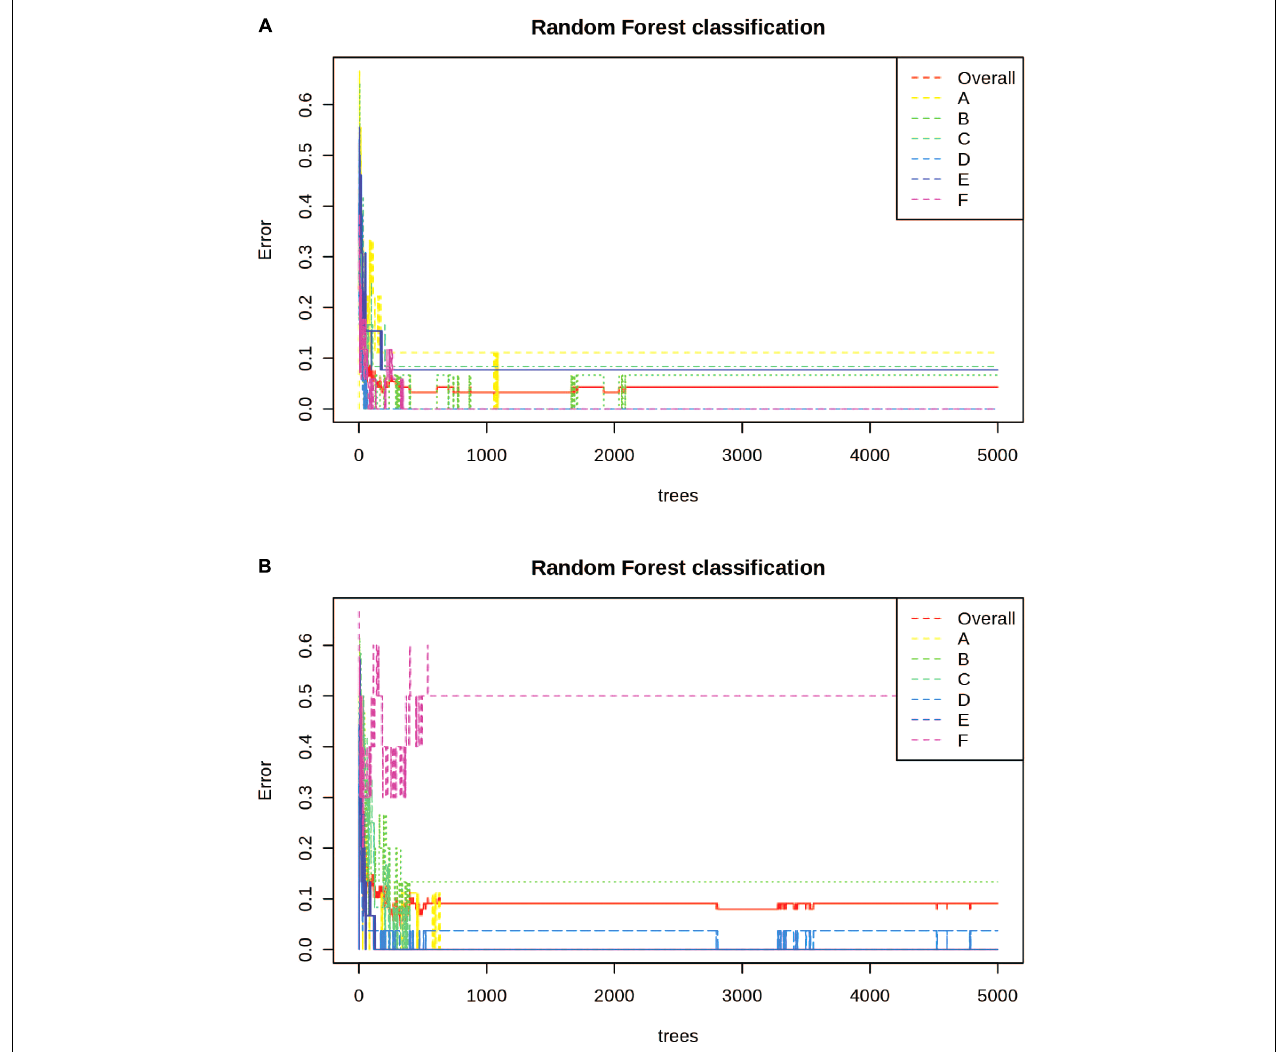
FIGURE 4 | Random Forests (RF) Classification of the differentiation between sites for alkaloid and phenolic extractions. Each color represents the cumulative error rates for the RF classification of each site as a unique class/chemoecotype. A site with a smaller error rate that is stabilized with a fewer number of decision trees is considered to be more accurately distinguished as a unique chemoecotype. The overall error rate for chemoecotype classification is shown as a red line. Site locations are color coded by the legend on this graph and labeled with ID’s (A–F) as found on Table 1 . The alkaloid extraction has the lowest overall error rate for classification of chemoecotypes, therefore chemoecotype groups are more easily distinguished or identified. (A) alkaloid extraction (B) phenolic